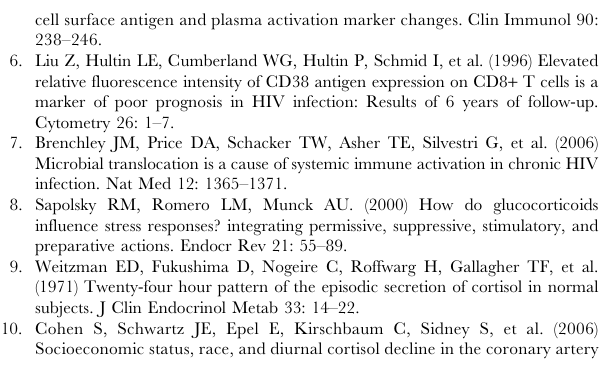
Percent of CD8 + T cells with CD38 + HLA-DR +